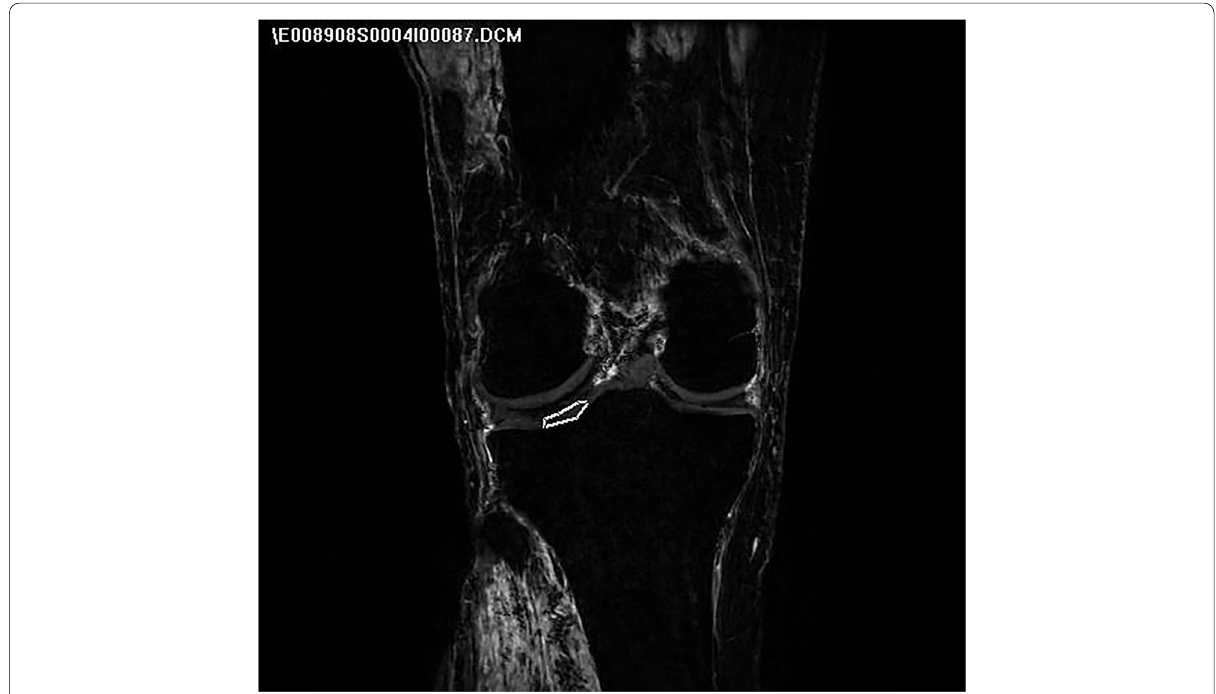
Fig. 2 Signal intensity was normalized against non-enhancing tibial plateau articular cartilage using coronal plane